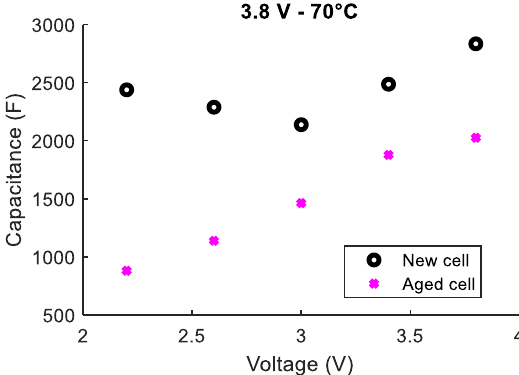
Figure 9. Comparison between the capacitances measured at 25 °C before and after aging for a LiC that aged at 3.8 V and 70 °C for 17 months.